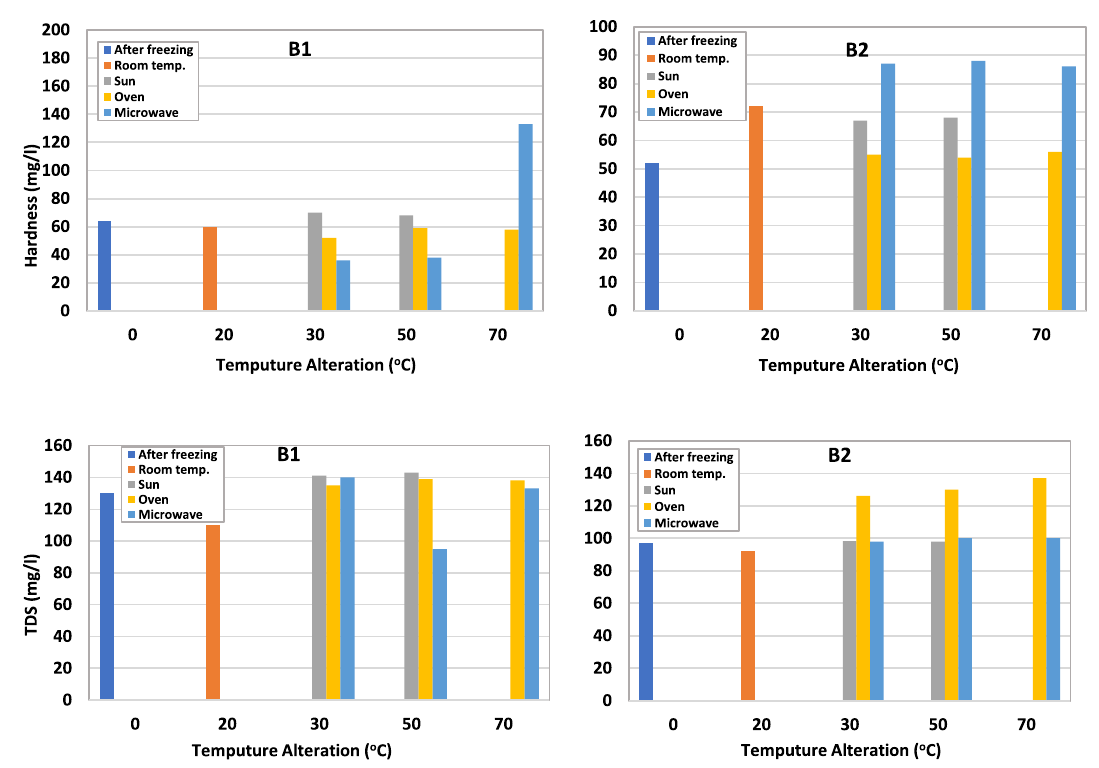
Fig. 3 Hardness and TDS measurements at different heating degrees for brands B1 and